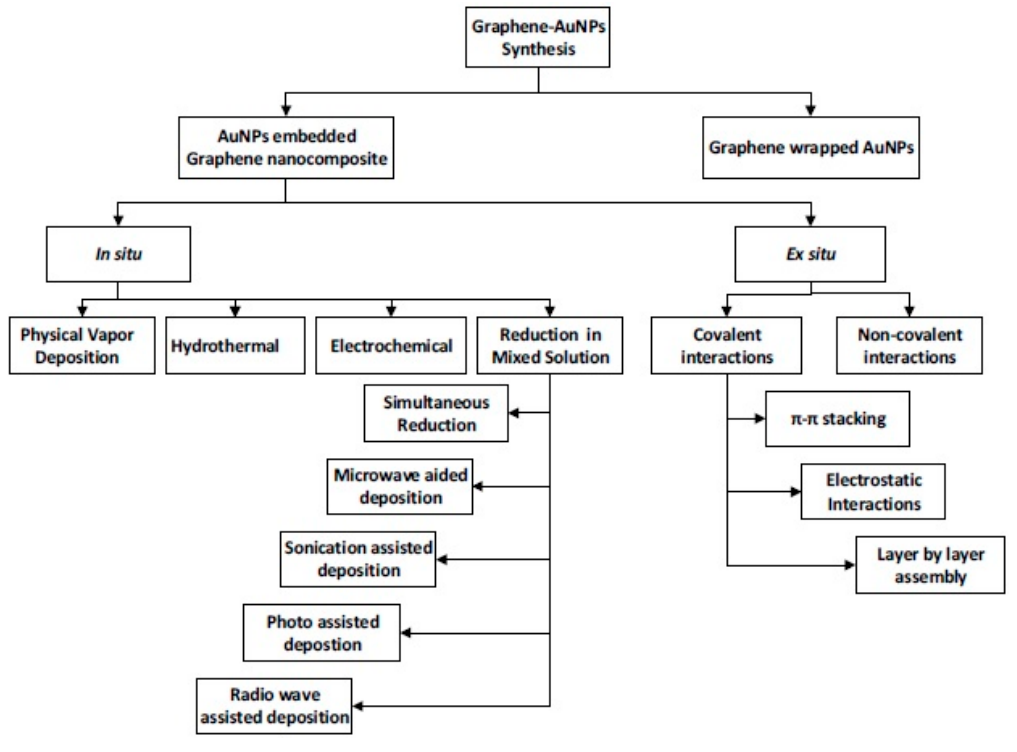
Figure 2. Formation of graphene–metal nano-composites by in situ and ex situ methods of preparation. (Reprinted (adapted) with permission from [2]; Authors Copyright © 2016, MDPI).